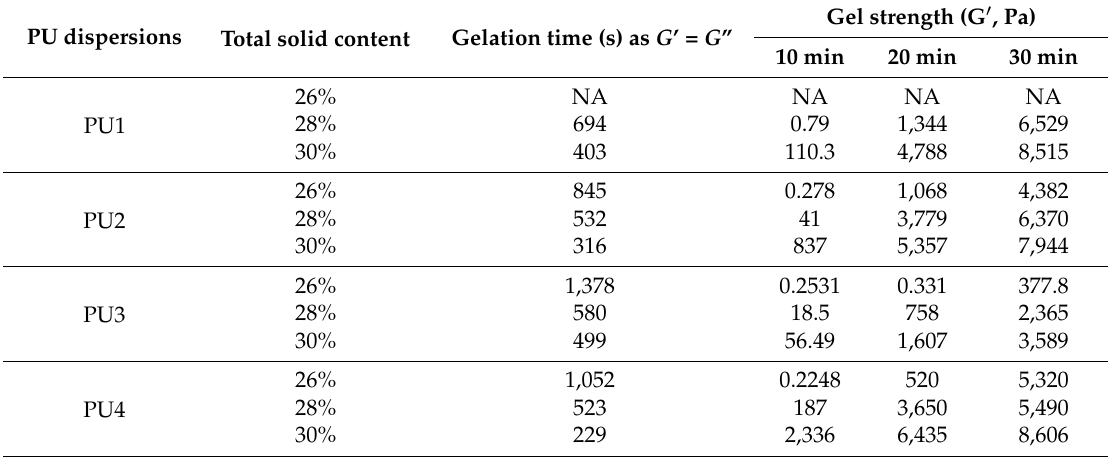
Table 2. The gelation time and time-dependent gel strength of PU